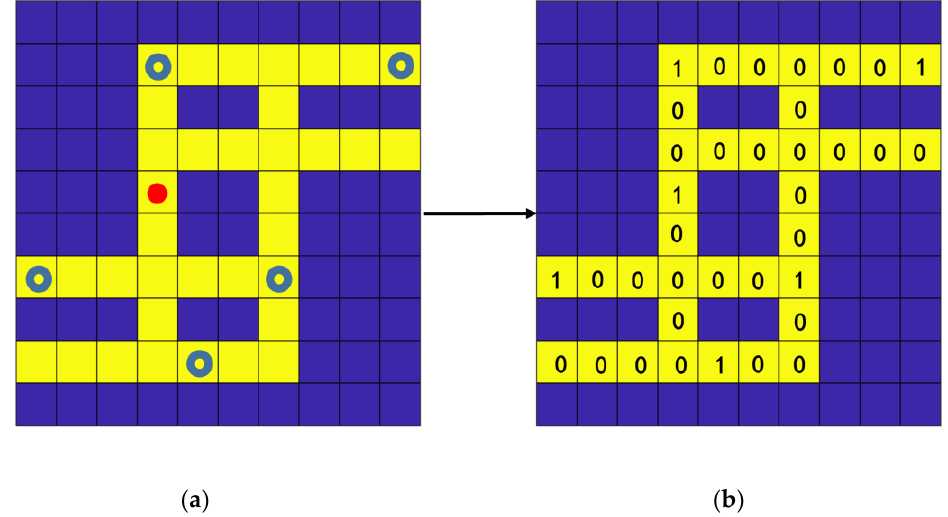
Figure 4. The well-placement and the optimal variables ( a ) The locations of wells (red point represents injection wells and blue represents production wells). ( b ) The optimal variables transformed from well locations.